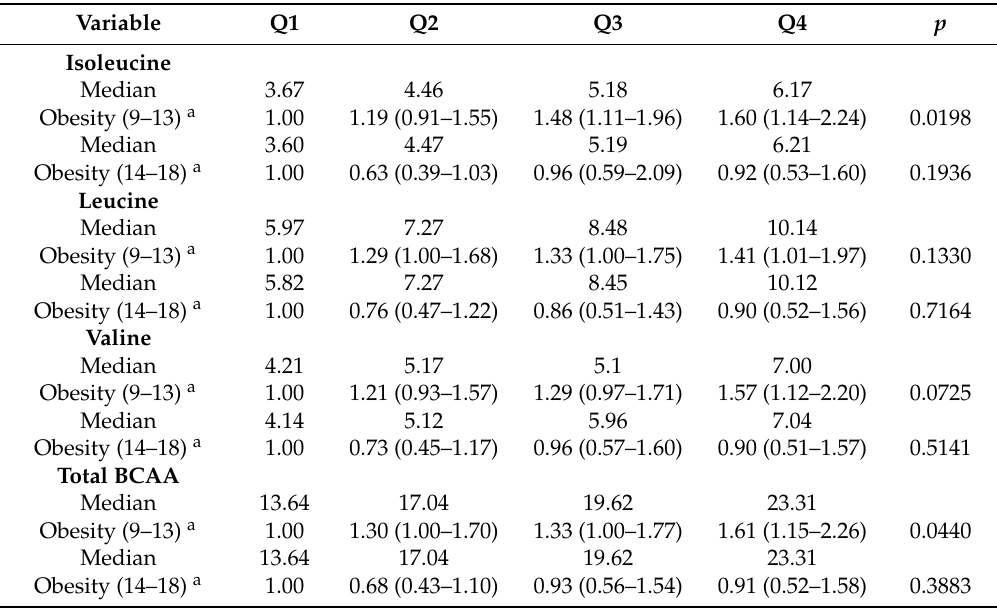
Table 3. Relationship between quartiles of BCAA intake and obesity in SPI collection stratified by age